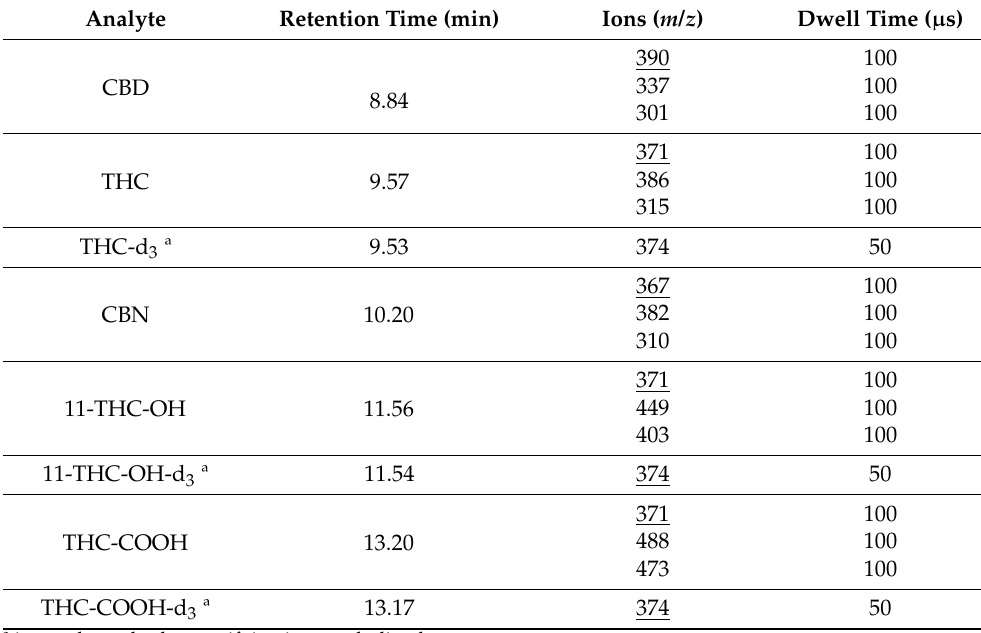
Table 7. Retention times and selected transitions for the identification of